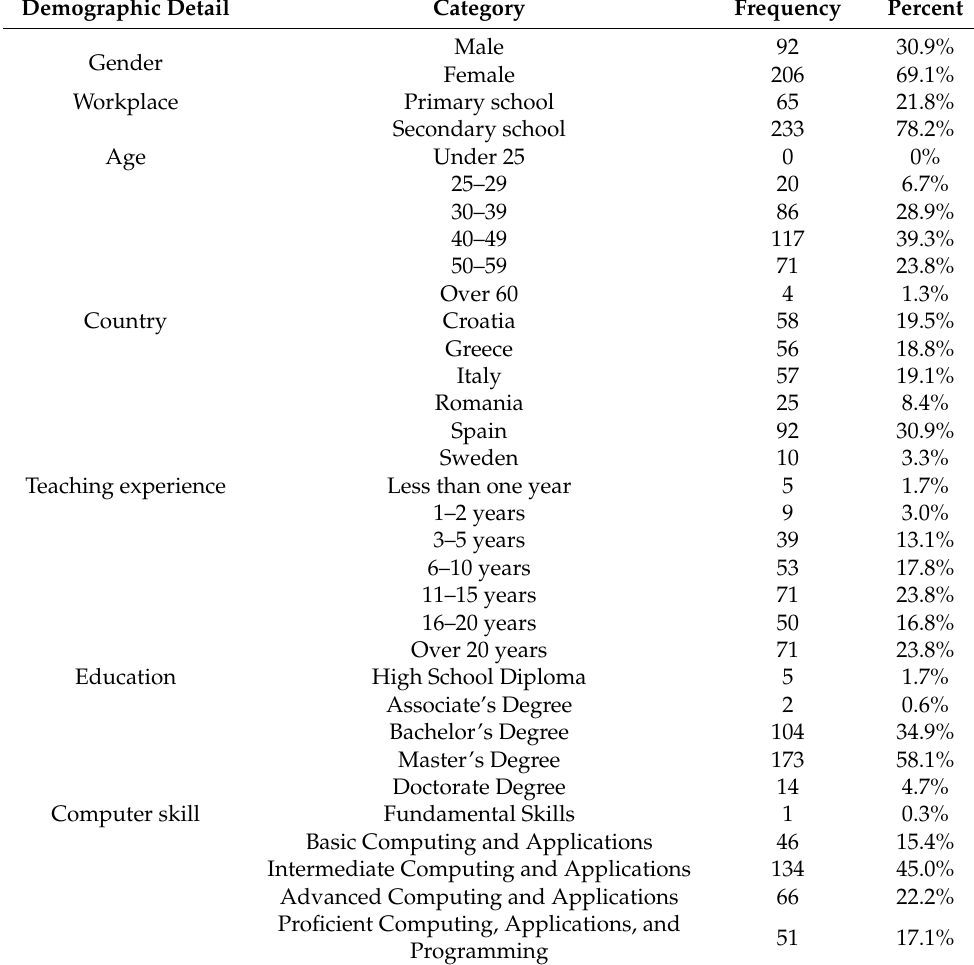
Table 1. Demographic characteristics of the sample (N =